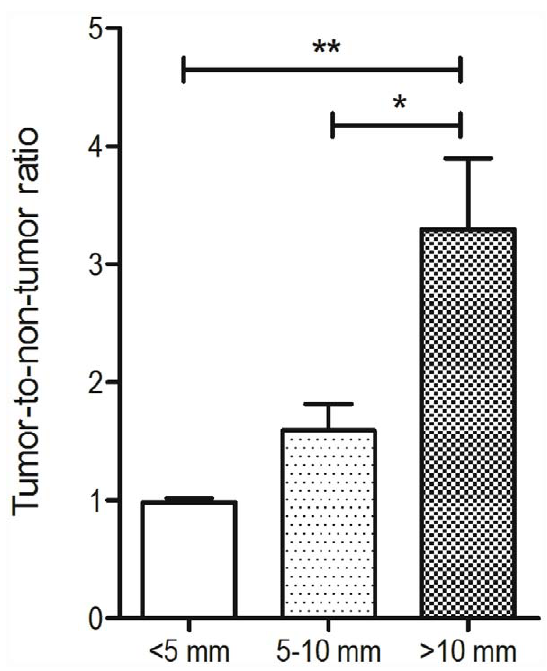
Figure 4. 18 F-FDG uptake to determine the tumor-to-non- tumor ratios in tumors of different size. Tumor-to-non-tumor ratio, determined by PET glucose imaging, was significantly increased in lesions . 10 mm. *p , 0.05. **p , 0.01.